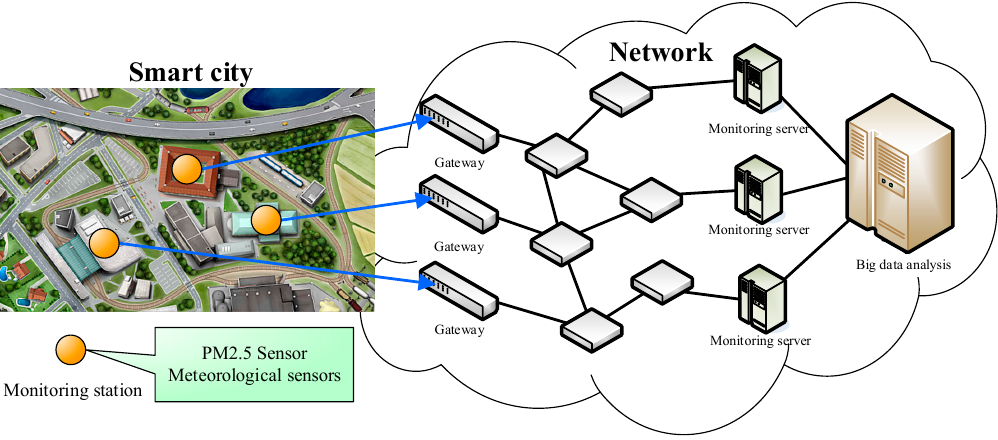
Figure 2. Urban sensing application in big data analysis; meteorological parameters: Temperature, Relative Humidity, and Precipitations.